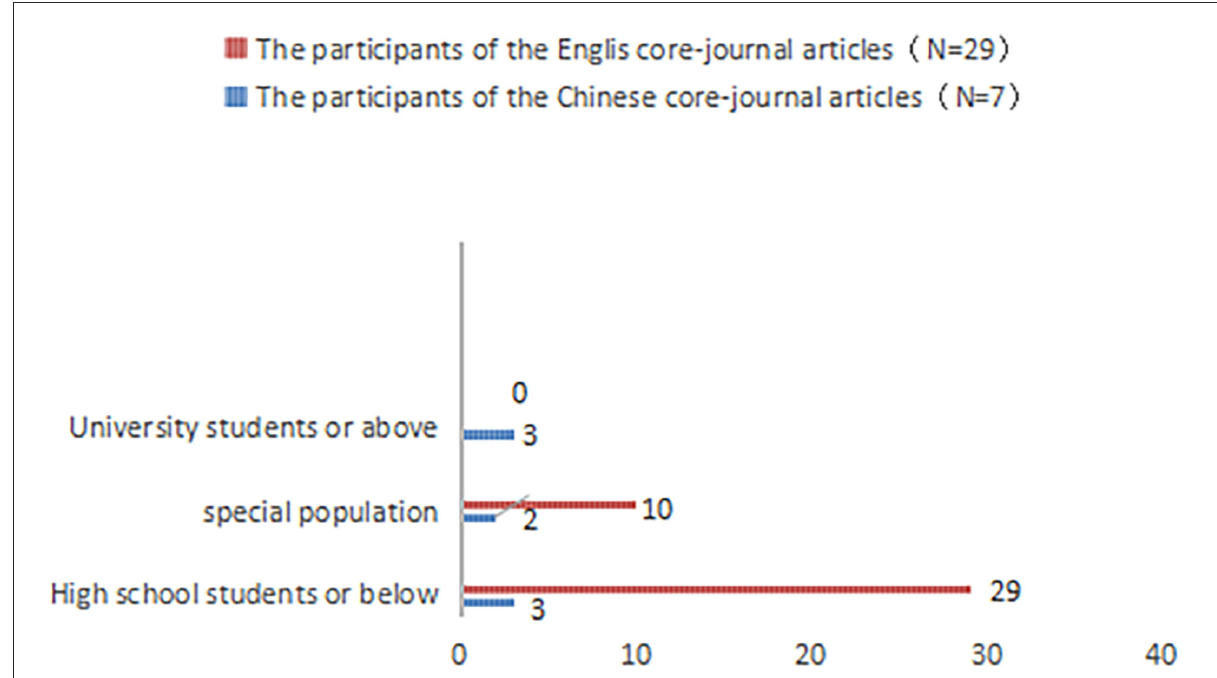
FIGURE6 The participants of the Chinese and English core-journals articles (note: some study participants involved both groups, for example, both high school students or below and special groups, so the total number in the figure may be greater than N